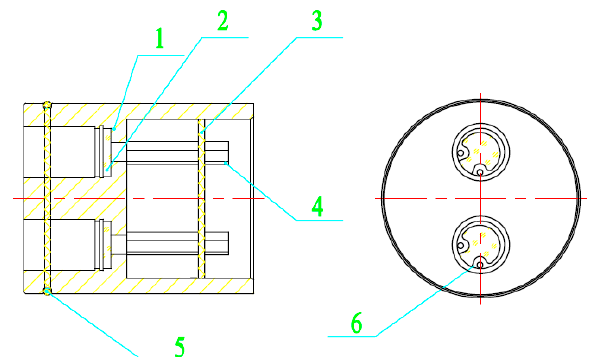
Figure 4. Structure of the downward optical sensor. 1: shield casing; 2: spectral filter; 3: the base of the photoelectric detector; 4: set screws; 5: filter; 6 compression spring.